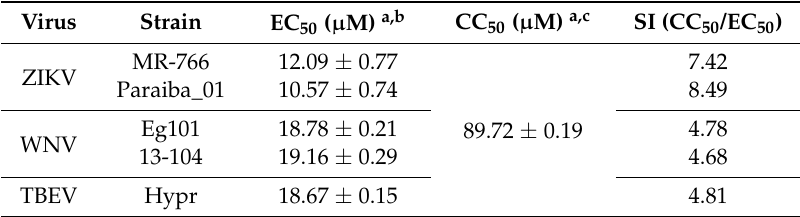
Table 2. Anti-flaviviral activity and cytotoxicity characteristics of arbidol in Vero